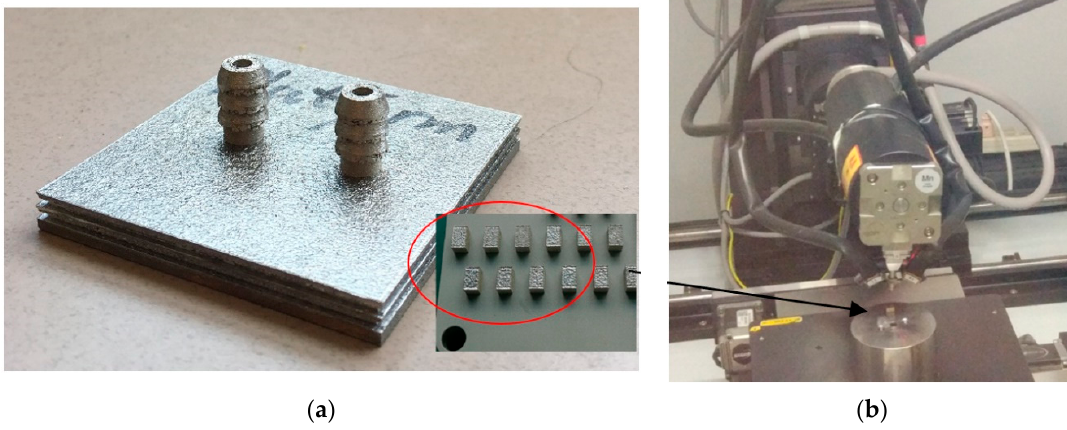
Figure 9. Printed samples and XRD residual stress tests: ( a ) part and samples; ( b ) sample test.